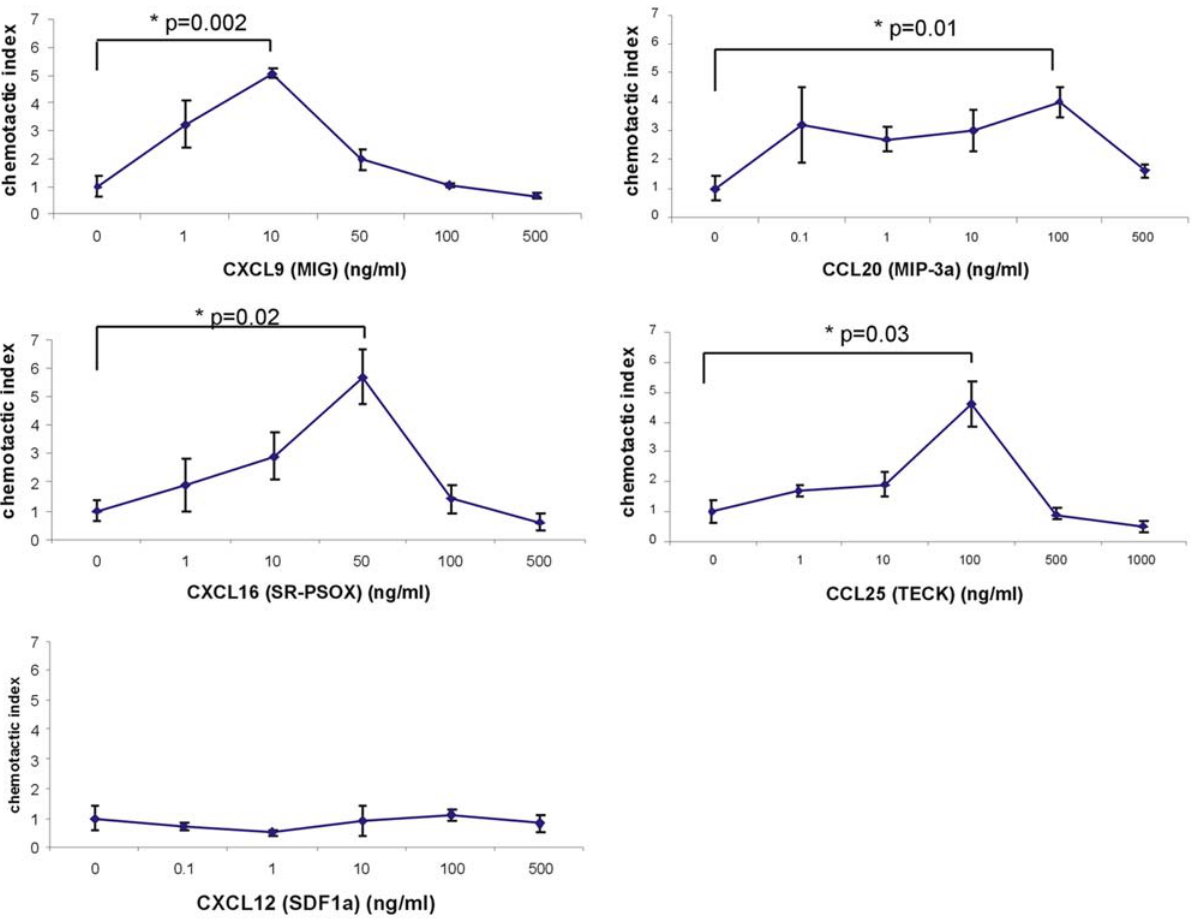
Figure 4. Analysis of murine chemokine receptor function by chemotaxis. Chemotaxis assays were performed on murine MSCs at passage 7. Each chemokine concentration was performed in triplicate per assay, and each assay was repeated three times. Results are expressed as the mean number of migrated cells over control cells (basal migration without chemotactic stimulus) (mean 6 SE; n=3), counted in five microscope fields of view at x130 magnification. * Denotes significant difference compared to negative control with no chemokine. The mean number of cells that migrated in the absence of chemokine, per field of view, was 12.1 6 3.2.